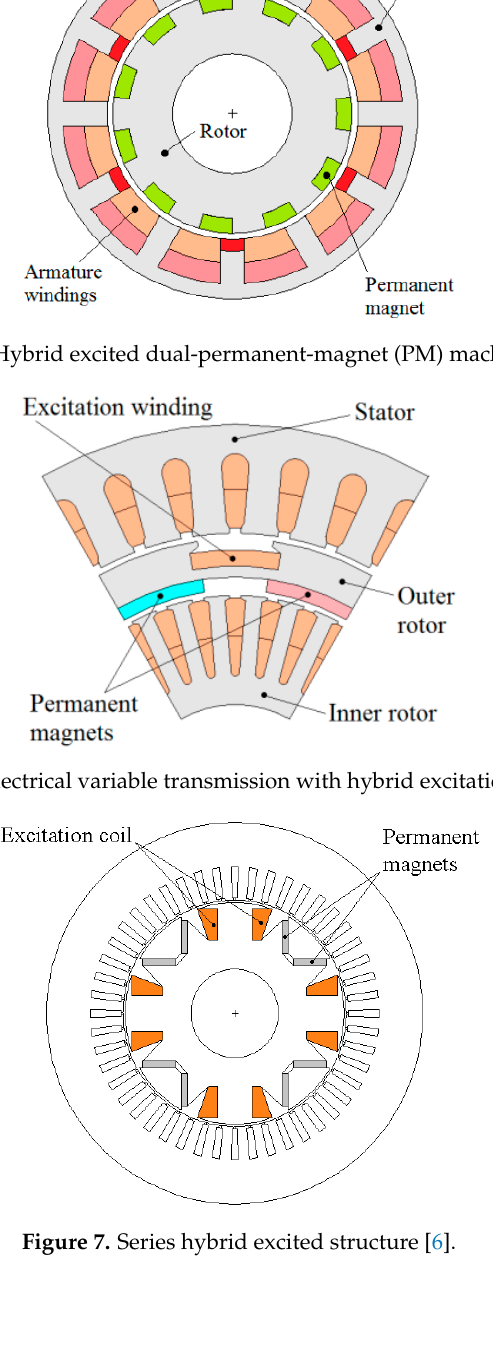
Figure 8. 3D parallel hybrid excited structures. ( a ) 3D juxtaposed structure [52]; ( b ) 3D imbricated structure [49,50].